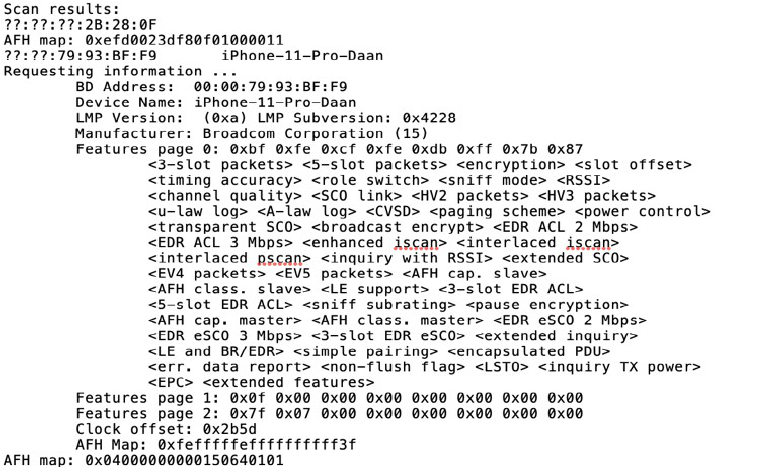
Figure 9. Retrieved UAP using the